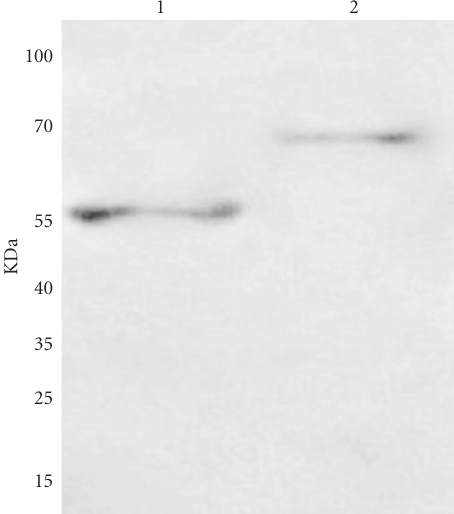
Figure 2: Western blot analysis using primary antibody anti-SEB and HRP-goat anti-rabbit IgG. lane 1: MG7-scFv/SEB protein after digestion with enterokinase; lane 2: MG7-scFv/SEB before digestion with enterokinase.